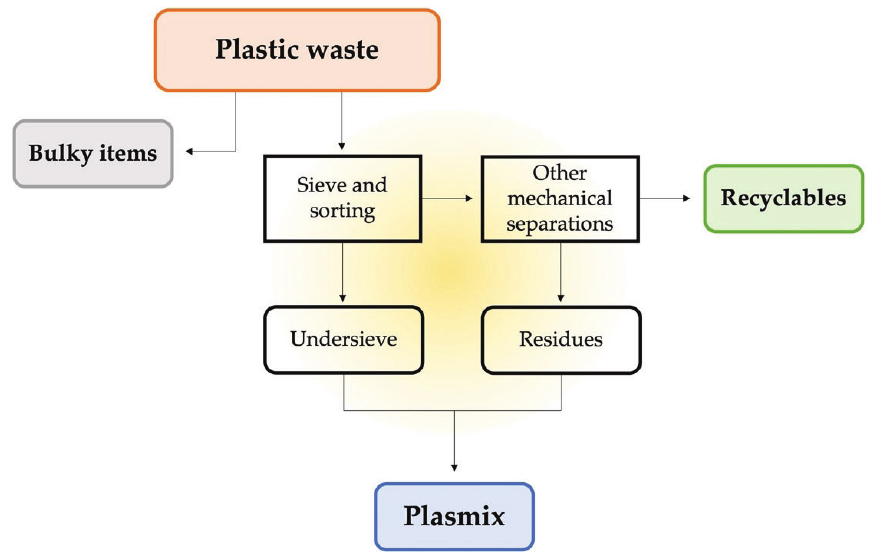
Figure 3. Pathways of Plasmix generation from plastic waste in Italy.